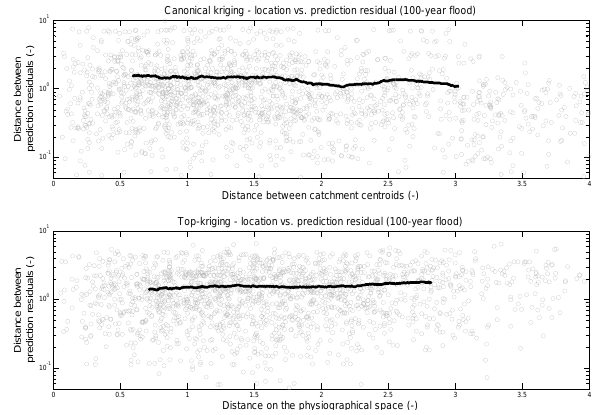
Fig. 7. Dimensionless distances between catchment locations and prediction residuals (gray circles); top panel: distances between catchment centroids in the geographical space (x-axis) and CK residuals (y-axis); bottom panel: distances between catchment pairs in the physiographical space (x-axis) and TK residuals (y-axis) (black thick line: running mean for 250